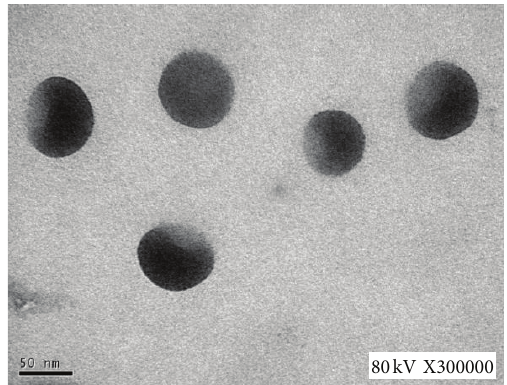
Figure 2: TEM image of curcumin loaded starch